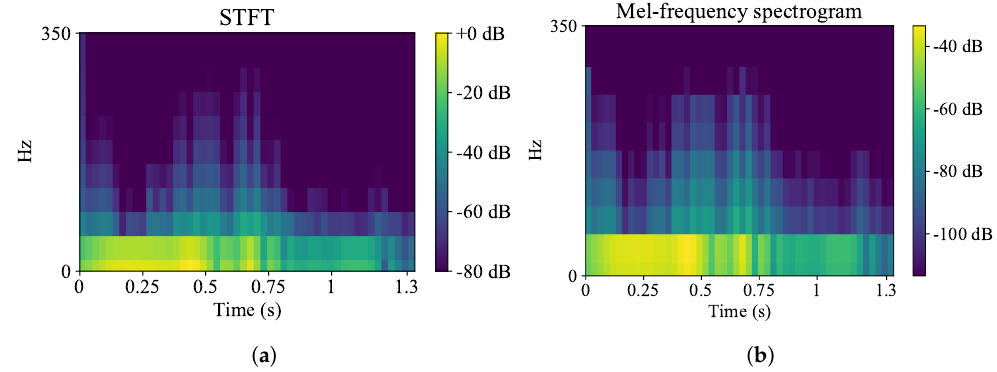
Figure 3. Initial spectrogram ( a ) and mel spectrogram ( b ) from one of the IMUs signals. The higher frequencies are attenuated after the mel